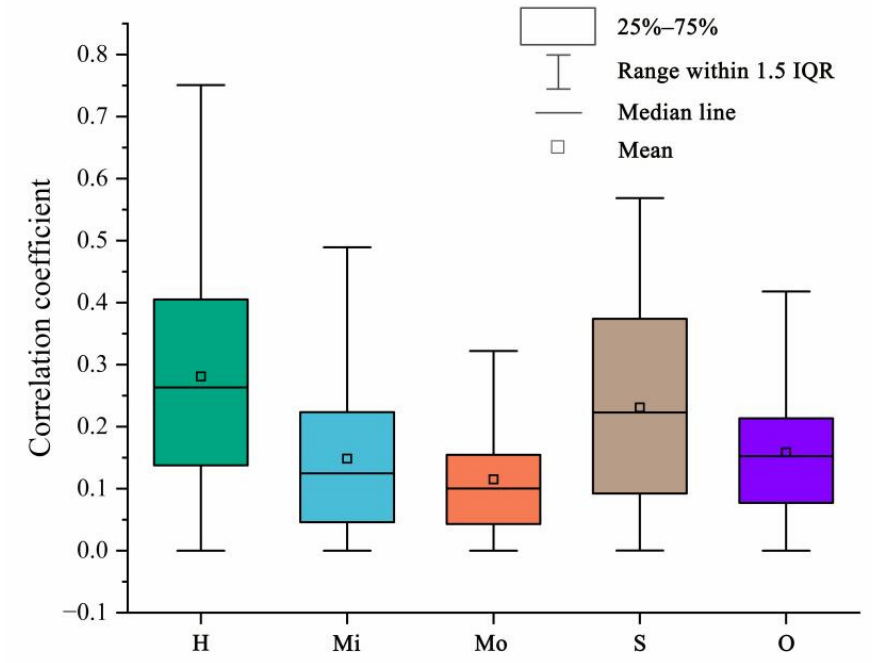
Figure 11. Changing trend of correlation between characteristic indices and leaf water content under different pest levels .